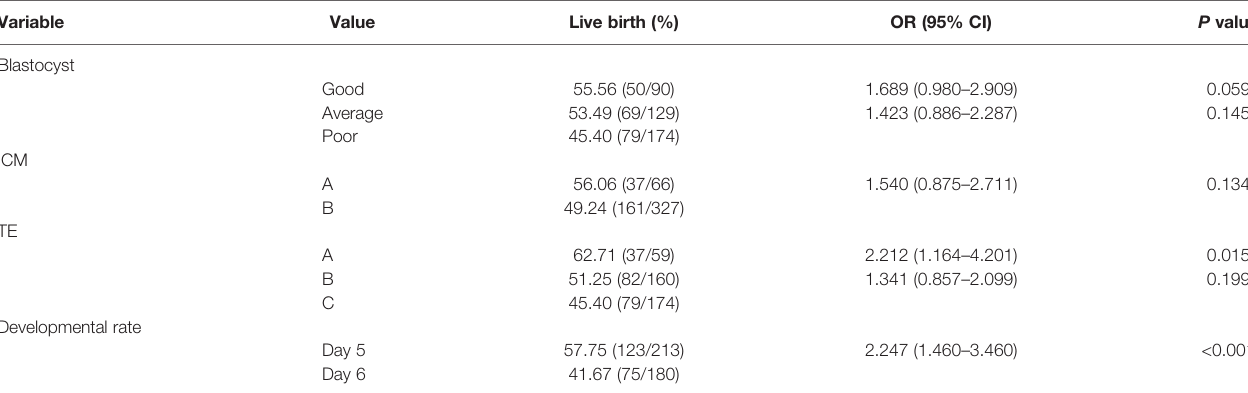
OR, odds ratio; CI, con fi dence interval; ICM, inner cell mass; TE, trophectoderm. The values for LBRs are adjusted for maternal age; maternal body-mass index; type of infertility; infertility diagnosis; number of prior pregnancies; endometrial preparation protocols and endometrial thickness on embryo transfer